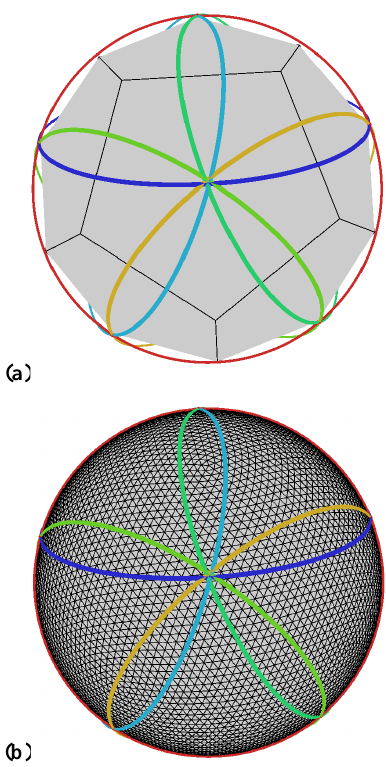
Fig. 2. (a) An overlapping subdivision of the sphere into N = 12 spherical caps. The cap centres t k are the projections onto the sphere of the centroids of the 12 pentagons of the inscribed regular icosahedron. Each coloured ring represents the edge of cap of radius r k . (b) A 10242 generator Delaunay triangulation by the parallel algorithm